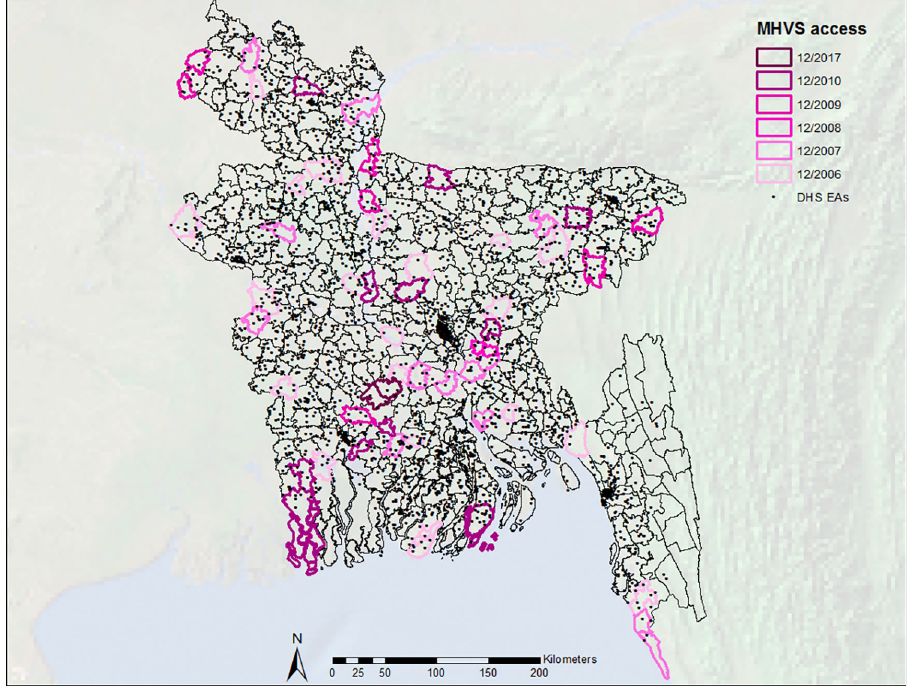
Fig 1. Implementation of the Bangladesh MHVS by year across subdistricts (upazilas) and locations of BDHS EAs, represented by points. AU : AbbreviationlistshavebeencompiledforthoseusedinFigs 1 (cid:0) 4 andTables 1 (cid:0) 3 : Pleaseverifythatallentriesarecorrect : Base layer extracted from the GADM database (www.gadm.org) version 3.6 (April 2018), available here: https://geodata.ucdavis.edu/gadm/gadm3.6/shp/gadm36_BGD_shp.zip. BDHS, Bangladesh Demographic and Health Survey; EA, enumeration area; MHVS, Maternal Health Voucher Scheme.